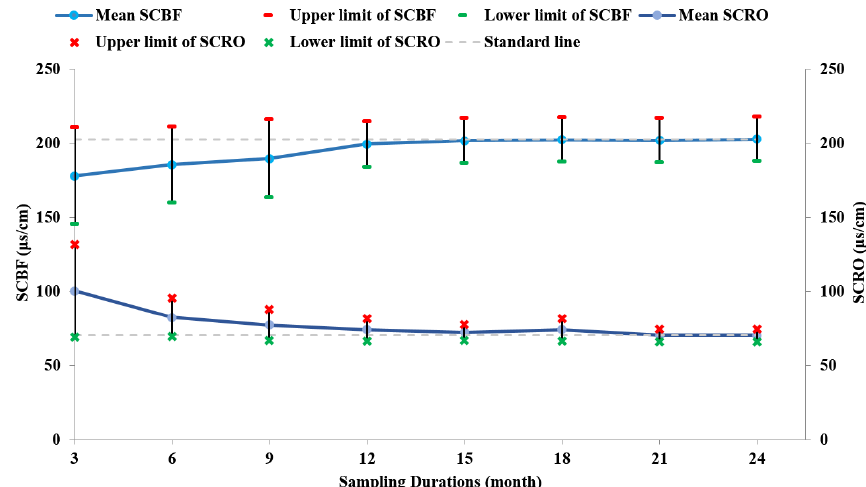
Figure 4. Values and variations of SC BF and SC RO with different sampling durations (error bars indicate ± 1SD – 1 standard deviation – for each sampling